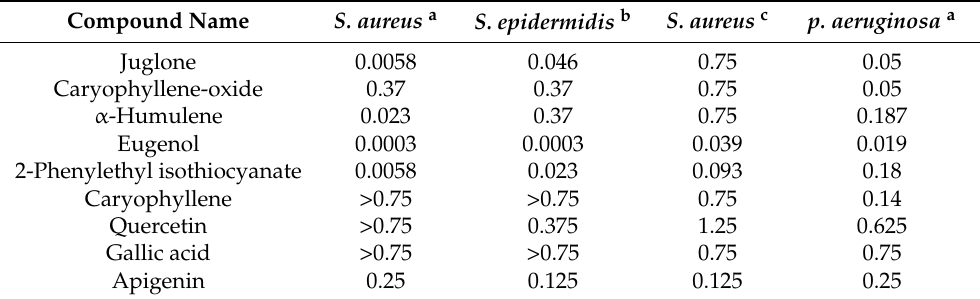
Table 6. MIC (mg/mL) of pure compounds against clinical and reference strains.